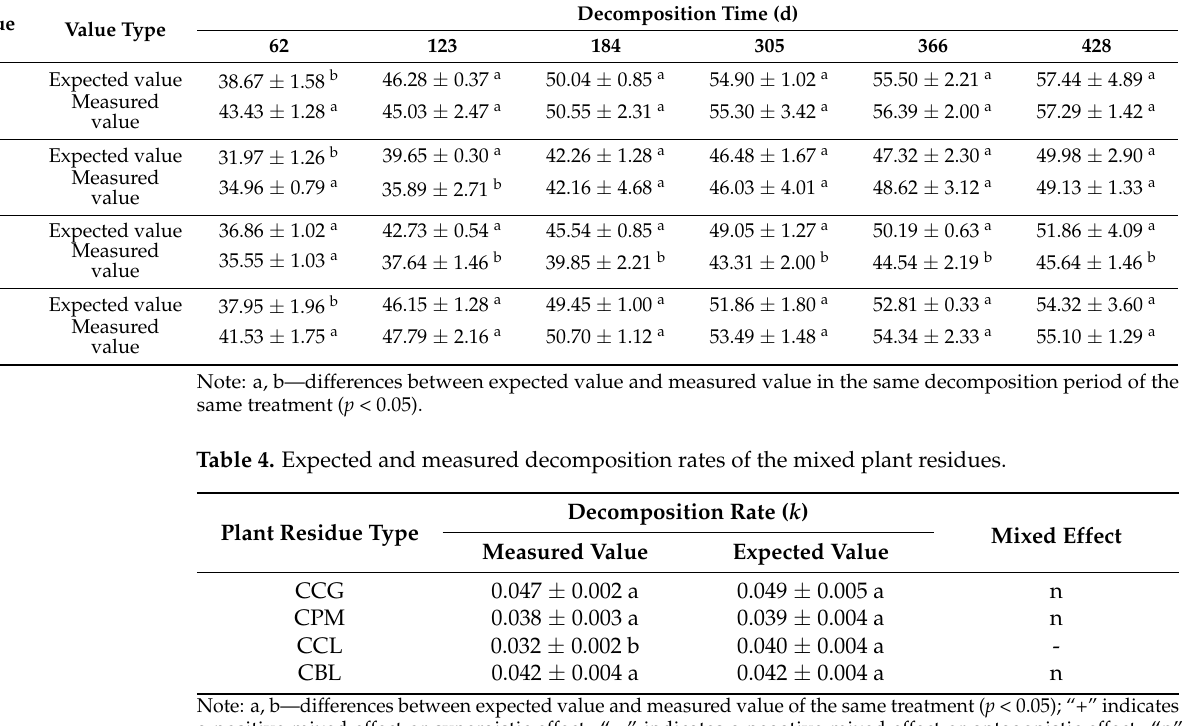
Table 3. Measured and expected mass decomposition rates of the mixed plant residues ( n = 3) %.